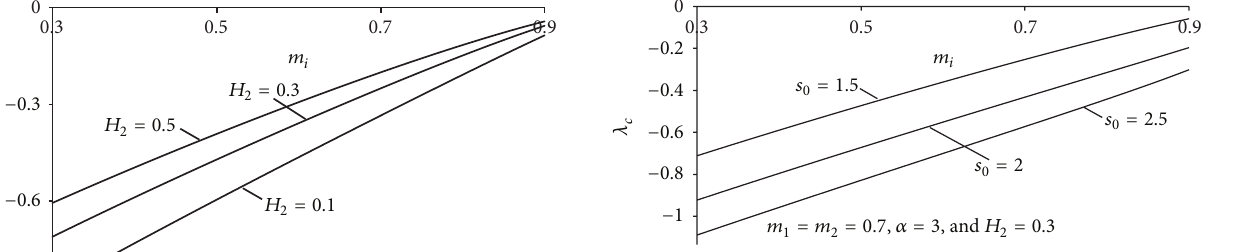
Figure7:Variationof 𝜆 𝑐 with 𝑚 𝑖 atdifferentvaluesof 𝑠 0 (otherinput parameters are